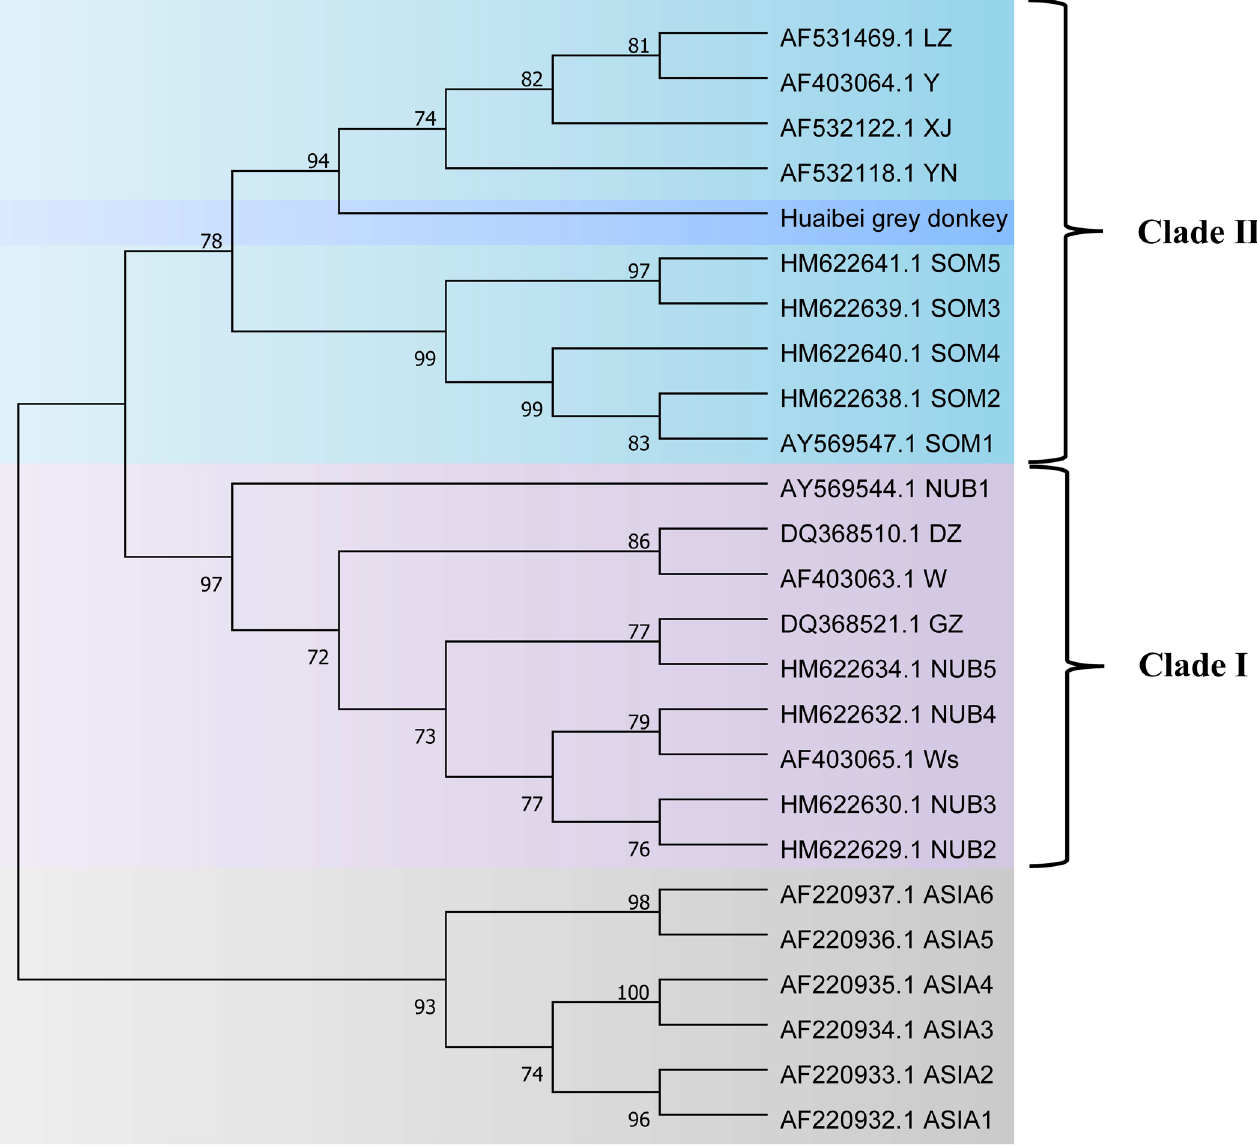
Figure 6. Phylogenetic relationships of Huaibei grey donkey determined using concatenated nucleotide sequences. Note: ASIA: Asian wild ass ( E. hemionus ), NUB: Nubian wild ass ( E. africanus africanus ), SOM: Somali wild ass ( E. africanus somaliensis ), LZ: Liangzhou donkey, XJ: Xinjiang donkey, YN: Yunnan donkey, DZ: Dezhou donkey, GZ: Guanzhong donkey, haplotype of Y, W, and Ws belong to European domestic donkeys.